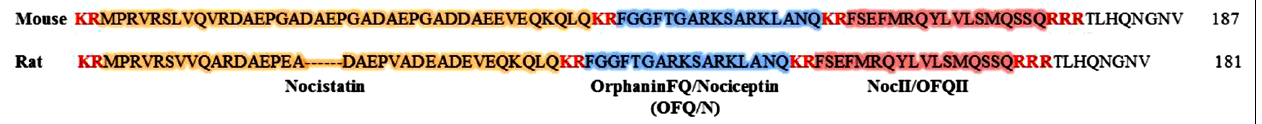
cleavage may occur at multiple sites along the ppOFQ/N peptide generating three biologically active neuropeptides; OrphaninFQ/Nociceptin (blue), Nocistatin (orange) and NocII/OFQII (red; Mollereau etal.,